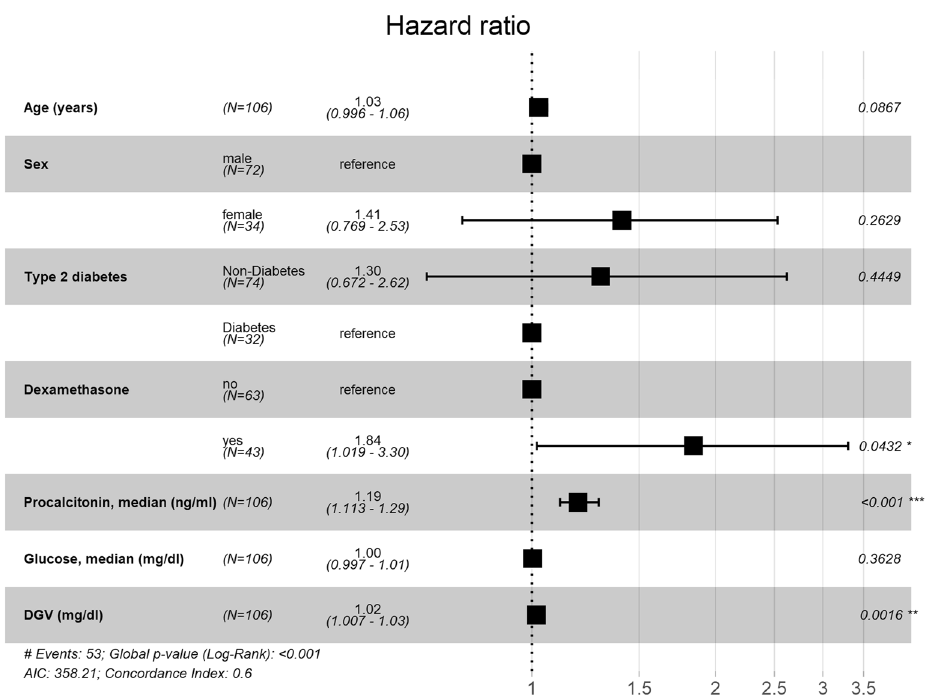
Figure 5. Adjusted hazard ratios for non-survival by DGV. Multivariable Cox proportional hazard model for median daily glycaemic variability (DGV) cut-off as a continuous covariate dichotomised at DGV ≥ 25.5 mg/dl, adjusted for clinically predetermined confounders: age, sex, type 2 diabetes status, dexamethasone treatment, median of procalcitonin, glucose and DGV during ICU